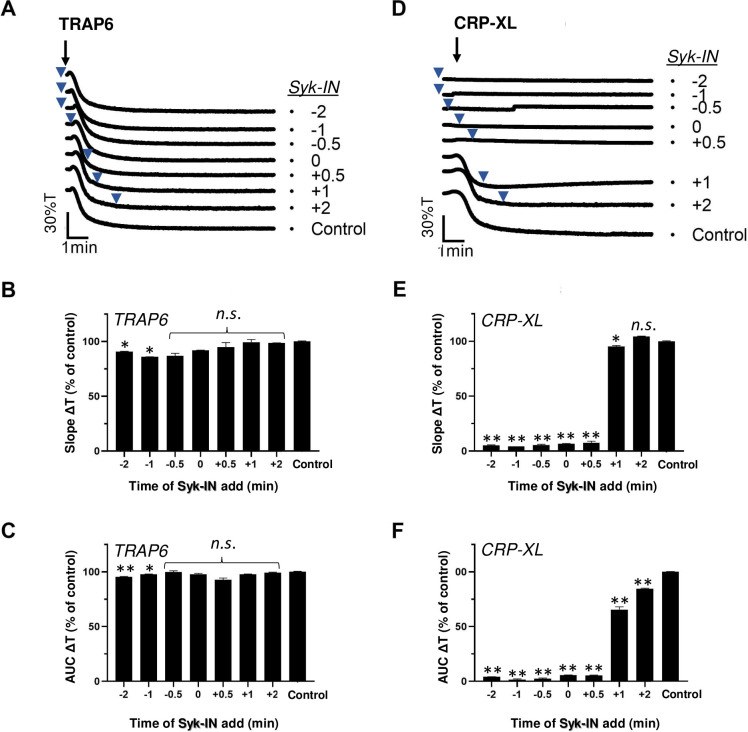
Post-hoc inhibitory effect of Syk blocker on CRP-XL-induced platelet aggregation.Platelets in suspension were stimulated with 10 μM TRAP6 (A-C) or 5 μg/mL CRP-XL (D-F), and aggregation was recorded by light transmission aggregometry. Syk-IN (5 μM) was added before (-2, -1 or -0.5 min), simultaneously with (0 min) or after (+0.5, +1, +2 min) the indicated agonist. Representative traces; arrows indicate addition of agonist, arrowheads addition of Syk-IN (A, D). Bar graphs of aggregation slope as%T/min (B, E) and aggregation-area-under-the-curve (AUC, 10 min) (C, F), expressed as fractions of control without Syk-IN. Means ± SEM (n = 3). *P<0.05, **P<0.001 vs. control traces, paired Student t-test.